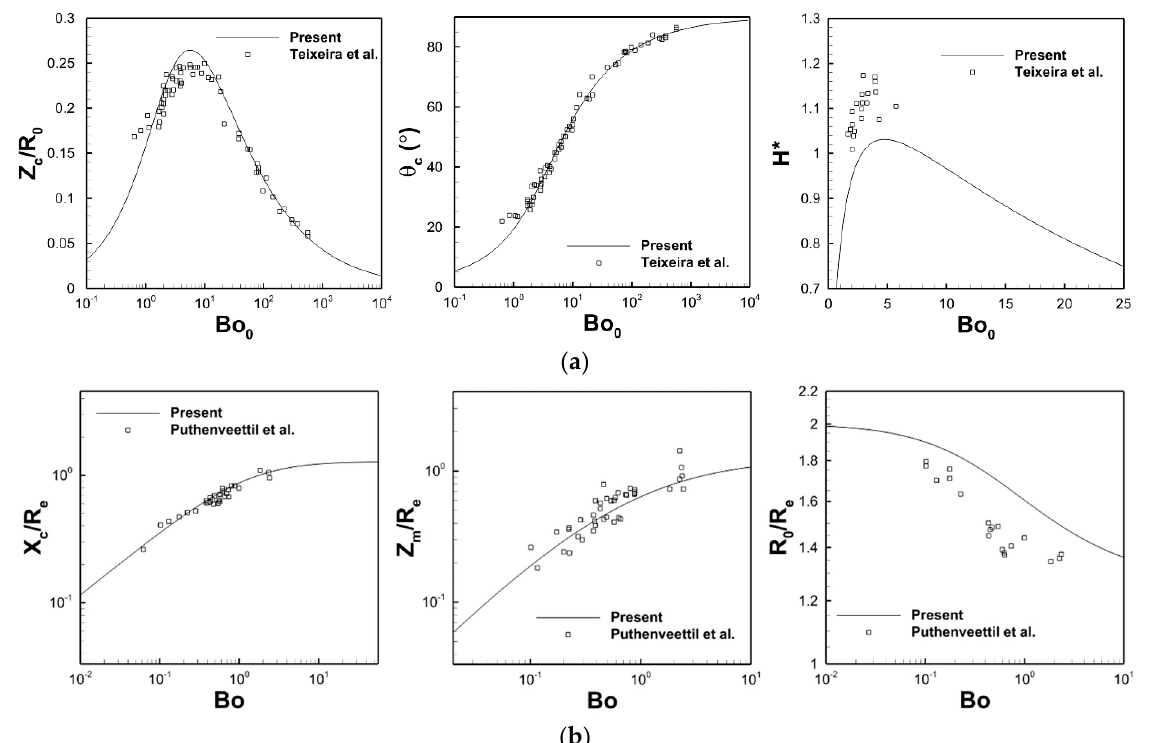
Figure 7. Comparison of the present numerical results with the experimental results of ( a ) Teixeira et al. [37] and ( b ) Puthenveettil et al. [36] for selected bubble parameters, where 𝐻 ∗ = √2𝐻